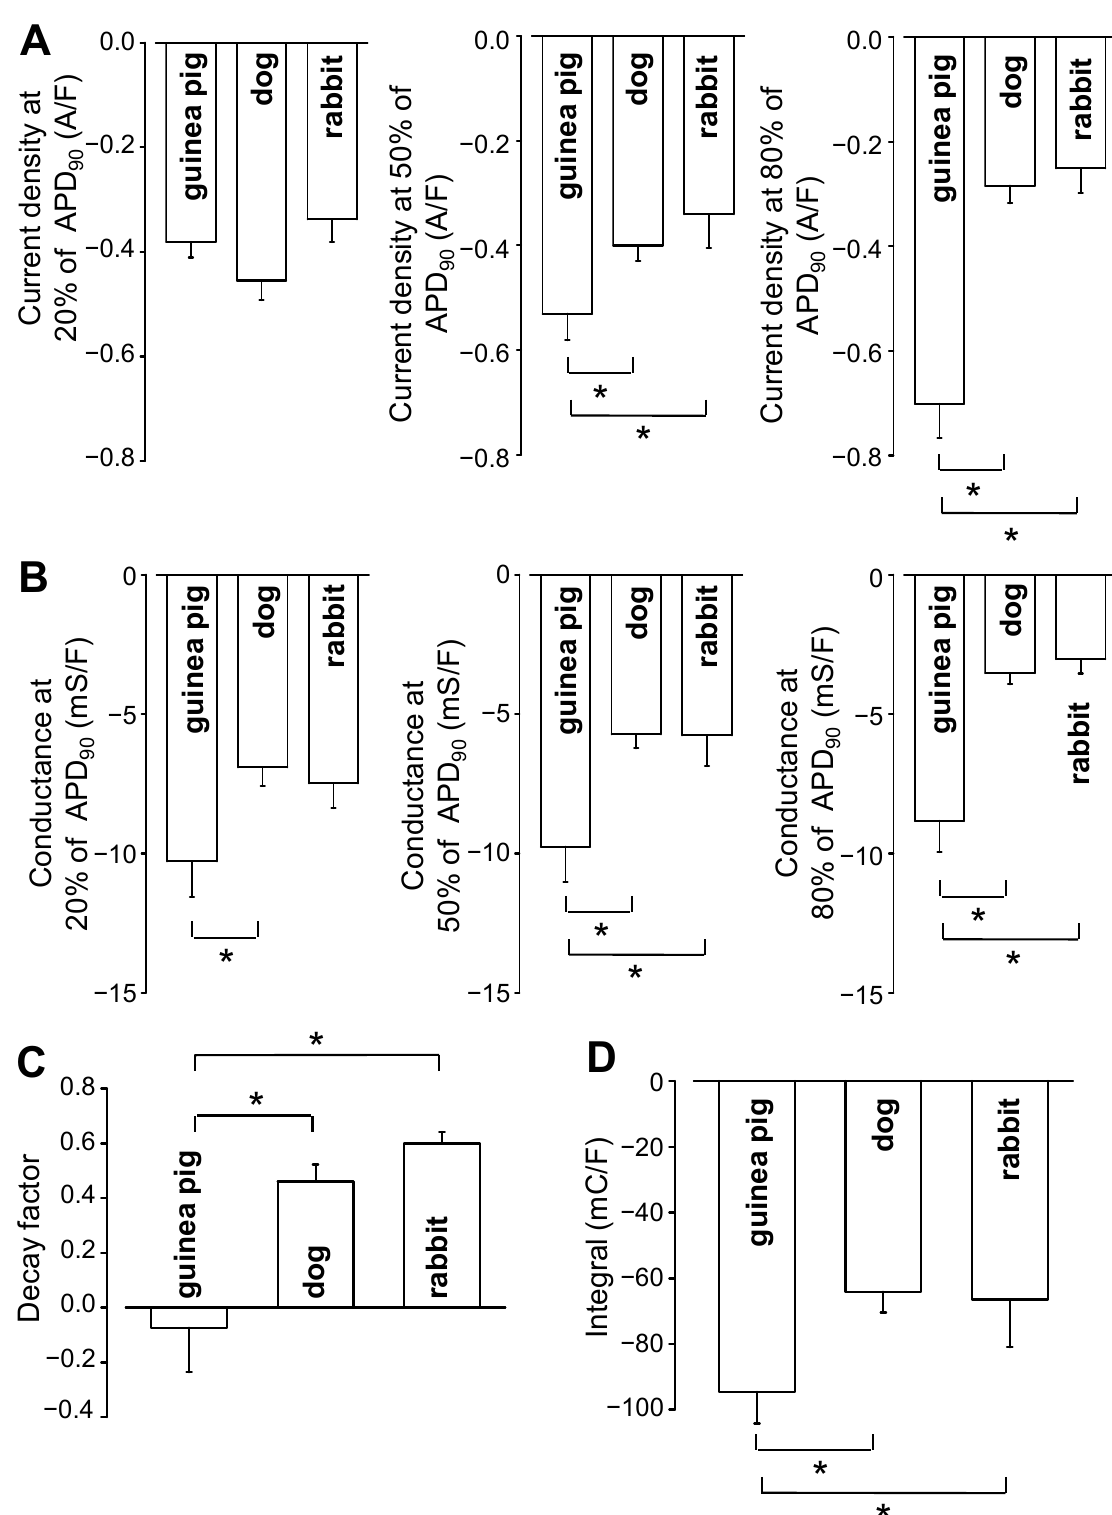
Figure 3. Average I Na,late ( A ) and G Na,late ( B ) values measured at 20%, 50%, and 80% of APD 90 in the canine, rabbit, and guinea pig myocytes, respectively. Decay factors (defined as G 20% − G 80% )/G 20% ) ( C ) and current integrals ( D ) obtained for 15 canine, six rabbit, and 18 guinea pig myocytes. Asterisks (*) denote significant differences ( p < 0.05) determined using the Student’s t -test for unpaired data.